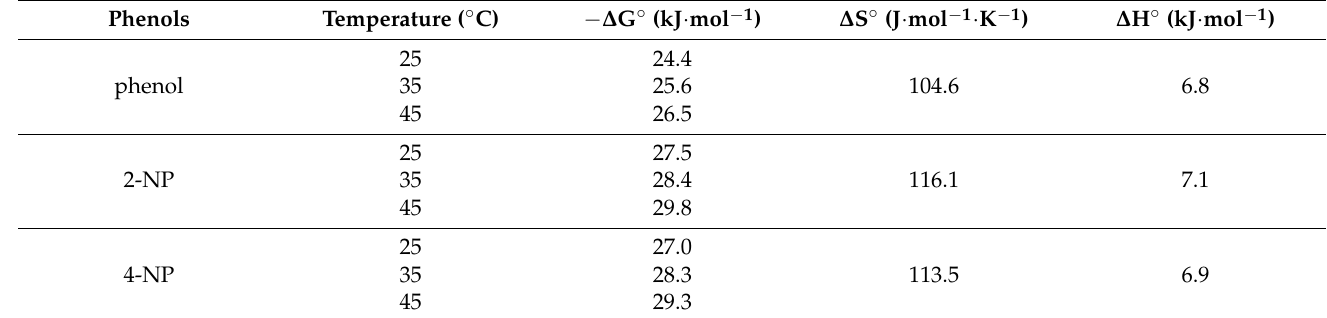
Table 3. Thermodynamic parameters for the removal of phenol and NPs on